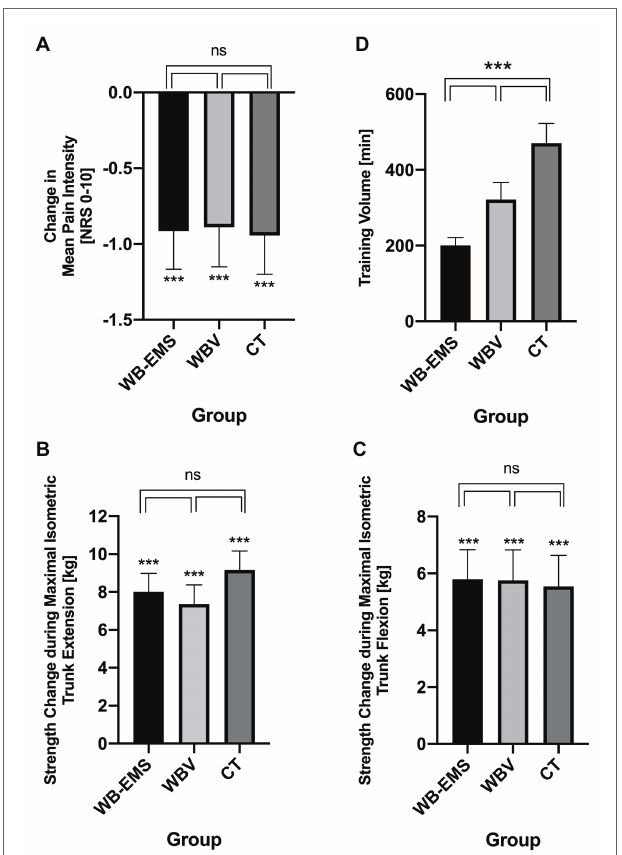
FIGURE 2 | Mean changes in pain intensity (A) , maximal isometric trunk extension (B) and trunk flexion (C) , and training volume (D) of the three intervention groups. Values are presented as means ± SD. *** p < 0.001; ns, not